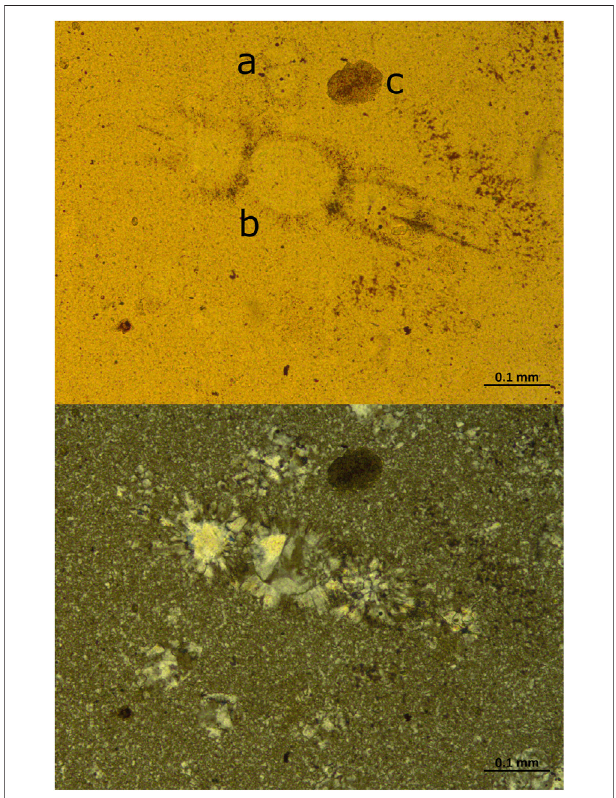
FIGURE7| Abuliminidforaminifer (a),inplane-polarized(PP)lightand in cross-polarized (XP) light, in a fl int sample from Wadi Qana. Also visible in this section:apartiallypreservednodosaridforaminifer(b),andapossiblesporeor pollen grain (c).